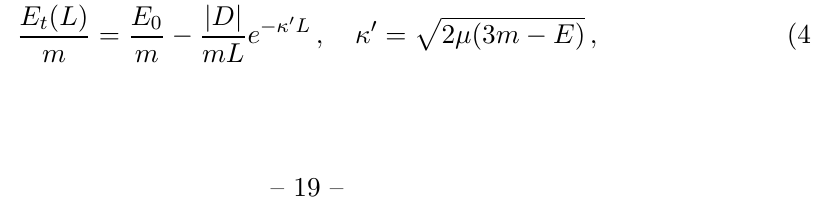
Figure 6 . Spectrum as a function of the box size for ma 0 = 16 and K iso the nonrelativistic energy. In order to facilitate comparison with ref. [40], the quantities plotted are made dimensionless using appropriate factors of a 0 , and thus di(cid:11)er from those in (cid:12)gures 4 and